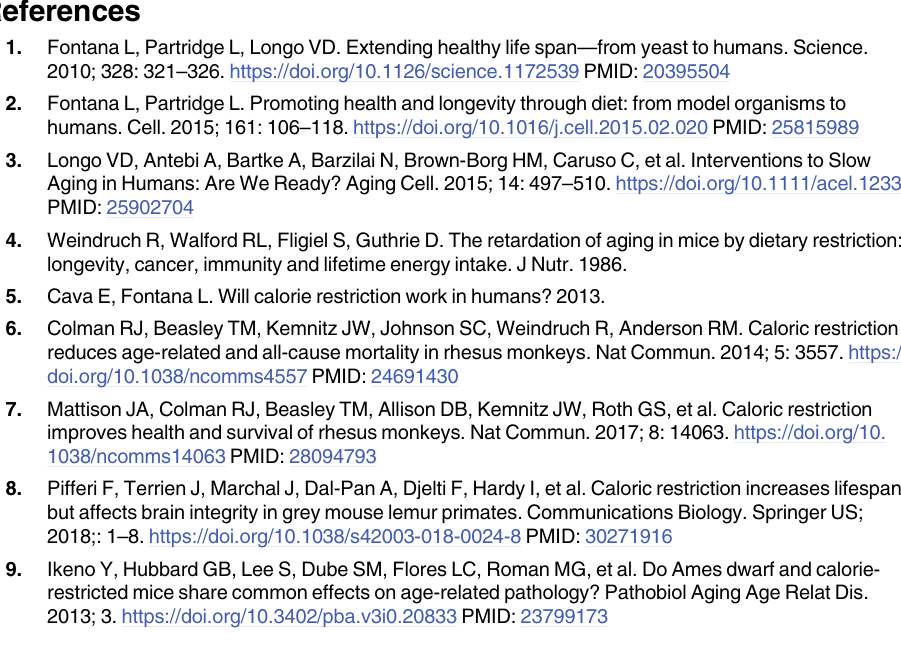
S19 Table. Methylation and expression comparison of genes associated with DR-related DMRs at old age. S20 Table. Functional enrichment of hypermethylated and down-regulated genes in old DR fed C3HB6F1 mice. S21 Table. Comparison of differentially expressed genes under DR in-vivo and in-vitro knockdown of Fgfr3. S22 Table. Functional enrichment of genes showing consistent differential expression in